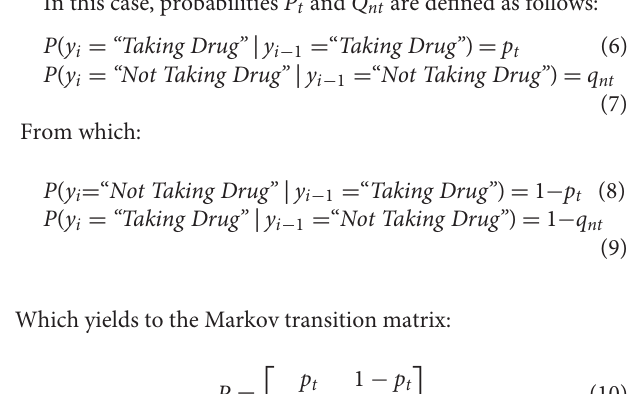
Frontiers in Pharmacology |